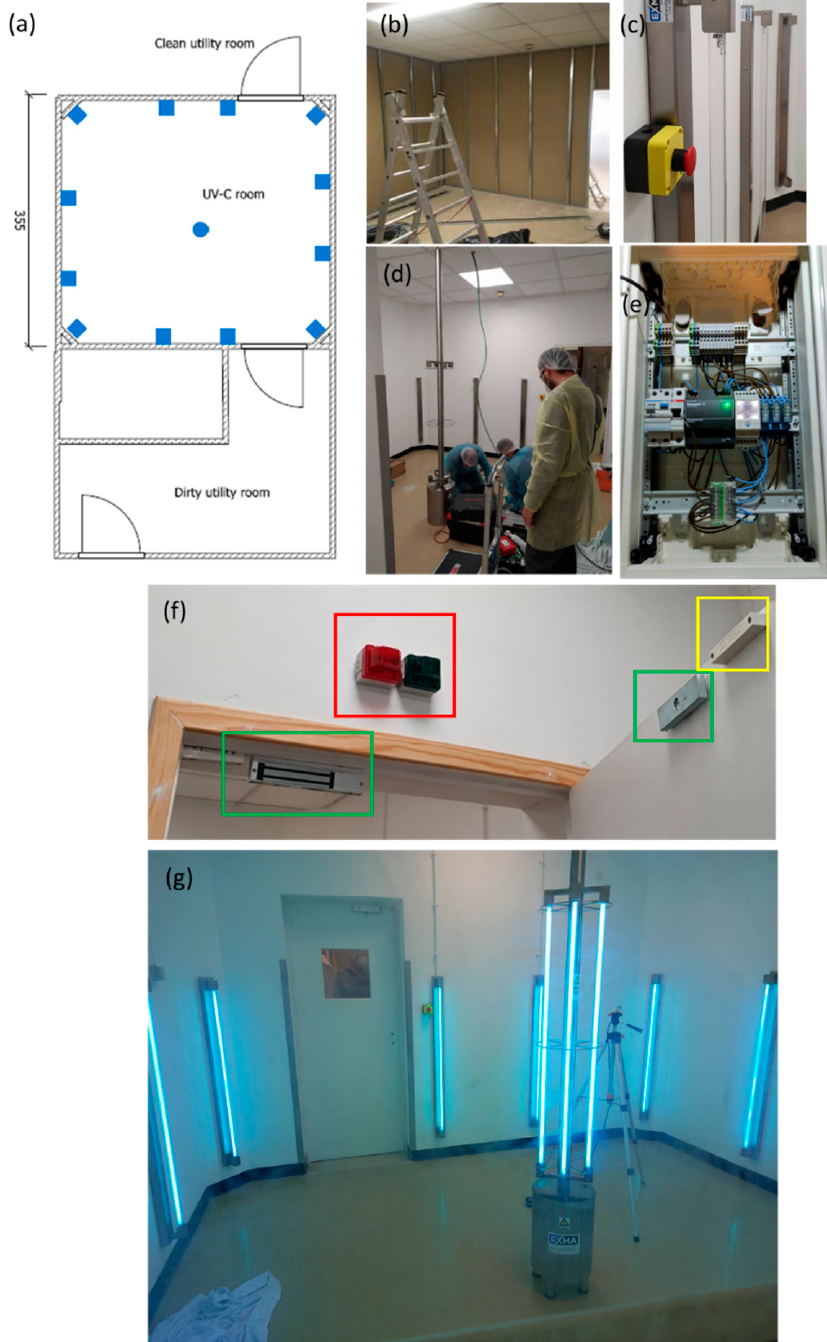
Figure 6. UV-C room. ( a ) blueprint, ( b ) initial construction phase, ( c ) emergency stop button, ( d ) final construction phase ( e ) wireless access to the control cabinet, ( f ) highlighted: in red—warning lights, in green—magnetic lock, in yellow—open/closed door sensor, and ( g ) UV-C room in operation. The UV-C irradiation of the room was mapped and is displayed in Figure